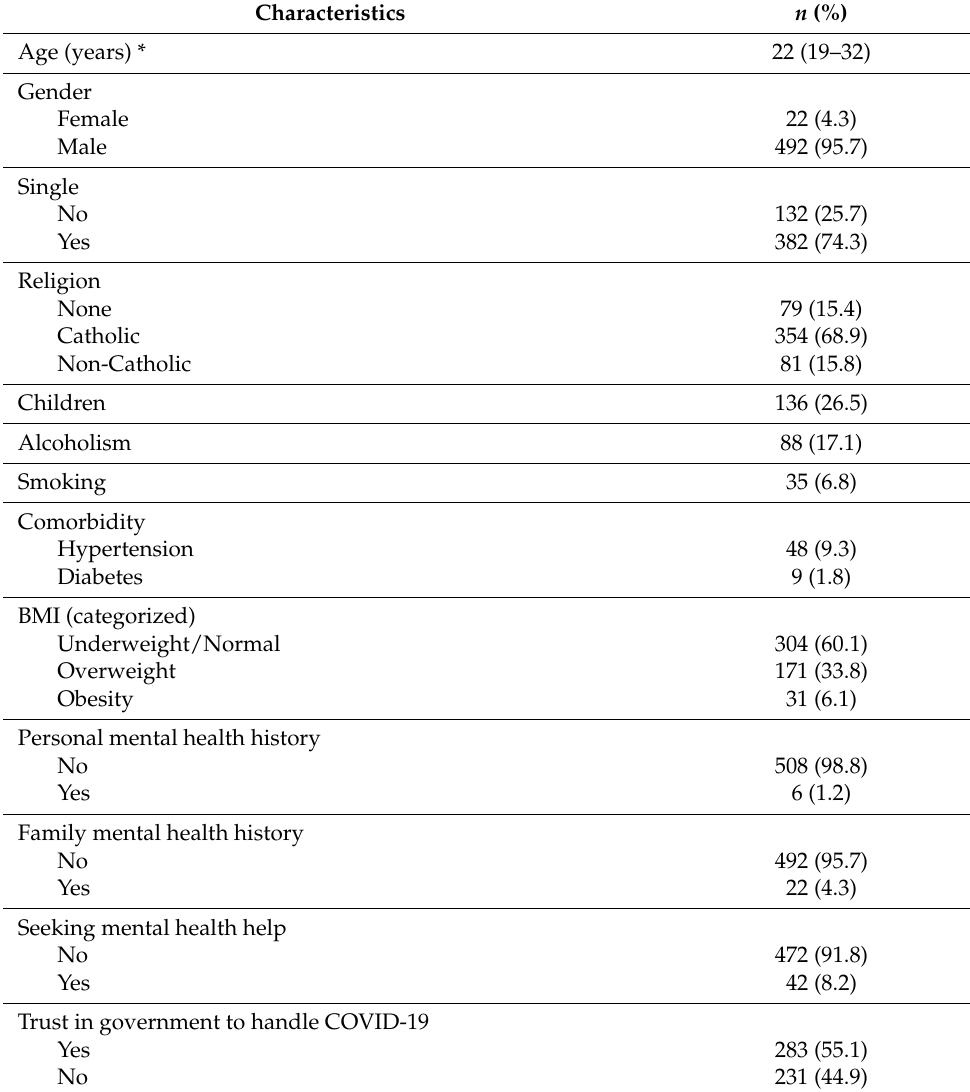
Table 1. Characteristics of military personnel ( n =